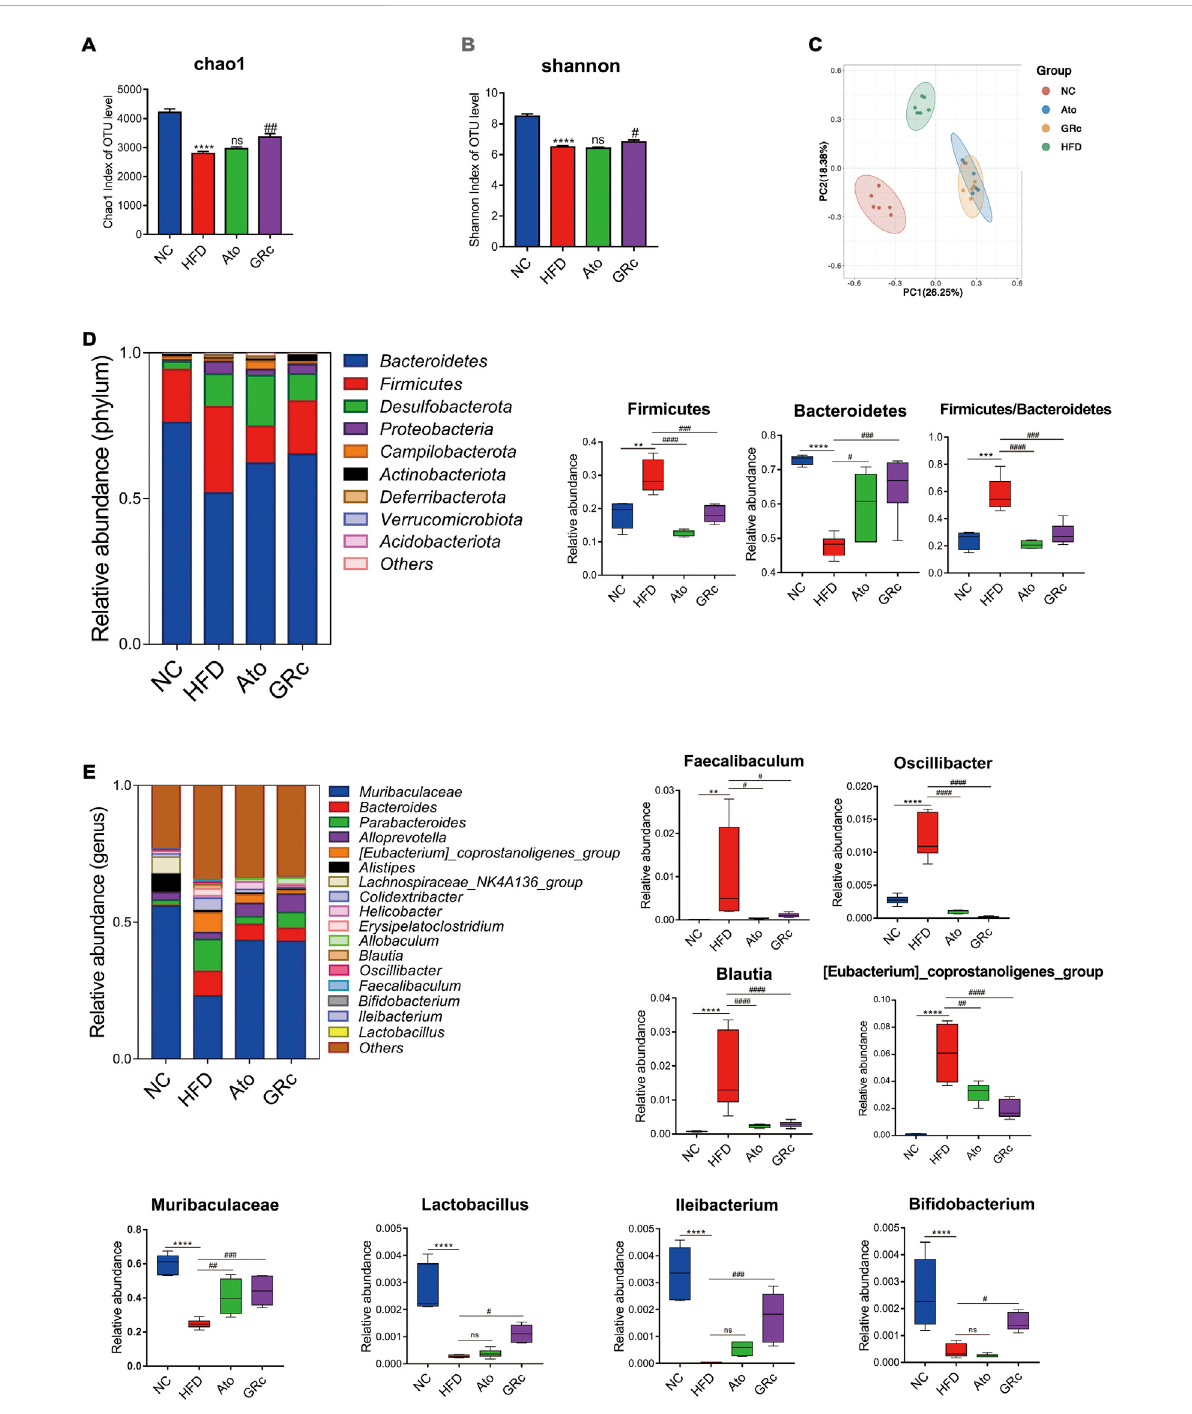
FIGURE 4 Effects of GRc on the composition of gut microbiota in HFD-induced ApoE − / − mice ( n = 6). (A – B) Richness and diversity of the gut microbiome were assessed by Chao1 and Shannon indexes, respectively. (C) PCoA analysis based on unweighted unifrac metrics for all samples at the OUT level. (D) Structure and relativeabundanceofFirmicutes andBacteroidetesatthephylum level andtheratioofFirmicutes/Bacteroidetes. (E) Structure and relative abundance of Muribaculaceae, Eubacterium_coprostanoligenes_group , Faecalibaculum , Oscillibacter , Blautia , Ileibacterium , Lactobacillus , and Bi fi dobacterium at the genus level. The data are expressed as means ± SEM. * p < 0.05, ** p < 0.01, and *** p < 0.001 vs. NC; # p < 0.05, ## p < 0.01, and ### p < 0.001 vs. HFD; ns, not signi fi cant; NC, normal control; HFD, high-fatdiet;Ato, atorvastatin; GRc,ginsenoside